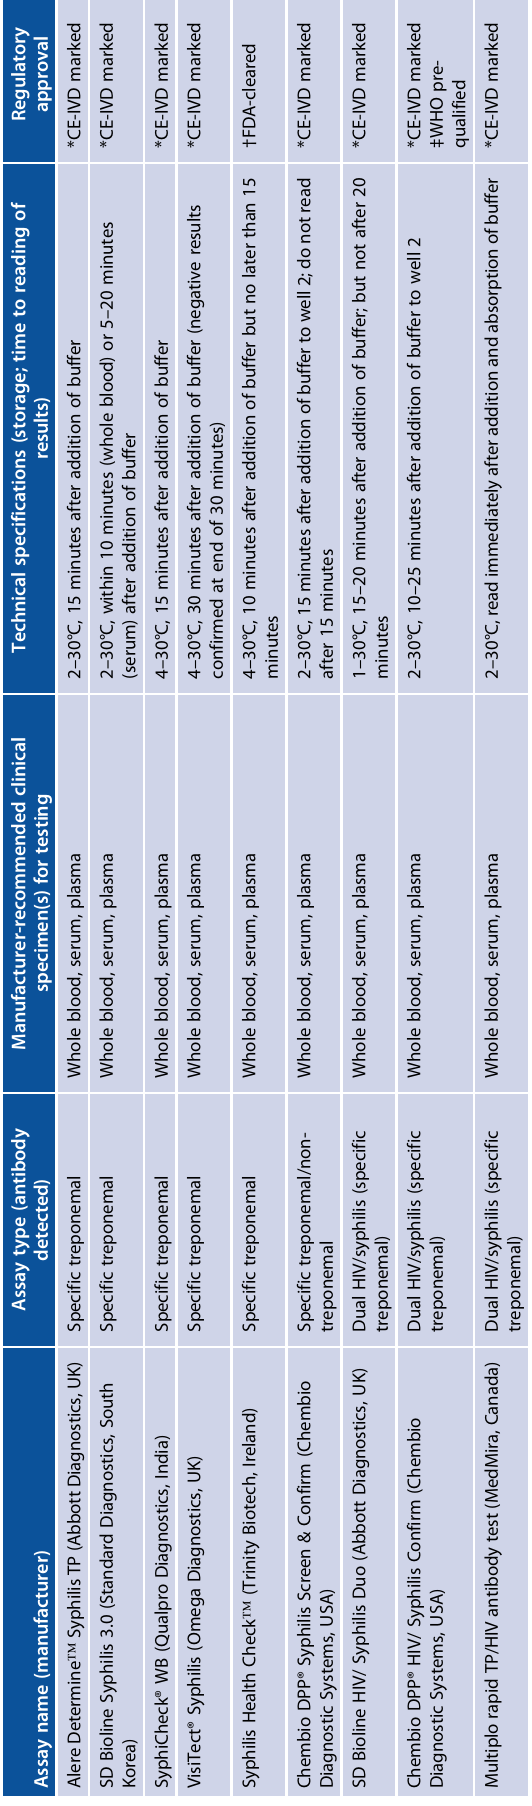
Non-treponemal tests Rapid plasma reagin (RPR) Venereal disease research laboratory (VDRL)